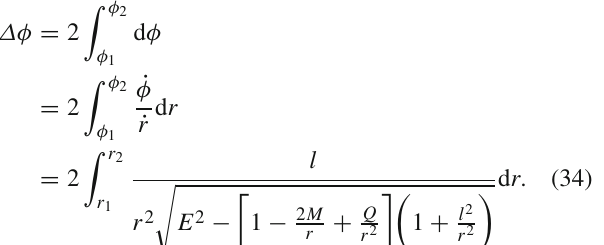
Fig. 8 Four leaves orbits around the DMPR brane-world black holes with (cid:14) = 0 . 5